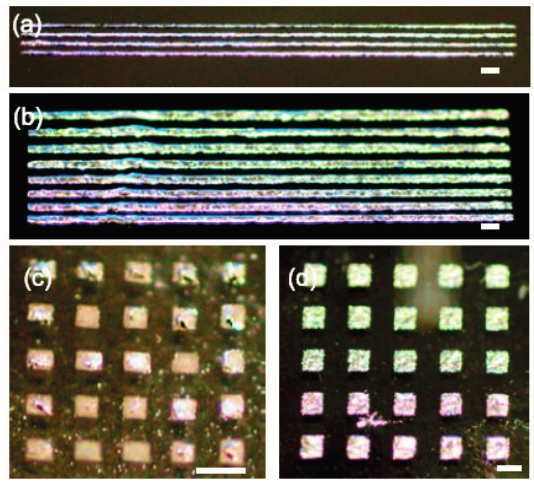
Figure 2. Printed patterns of liquid alloy on PDMS using tape transfer printing: ( a ) Line patterns of 200 μ m width with a space of 500 μ m; ( b ) Line pattern of 500 μ m width with different spacing, Square dot patterns of ( c ) 500 μ m; and ( d ) 1 mm. The scale bar is 1 mm.